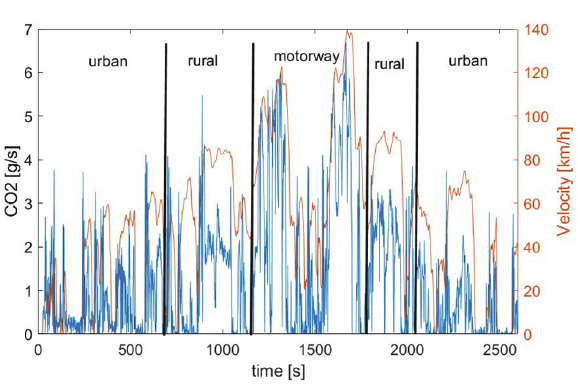
Fig, 6. Emission intensity of CO 2 for Euro 6 LPG fuelled